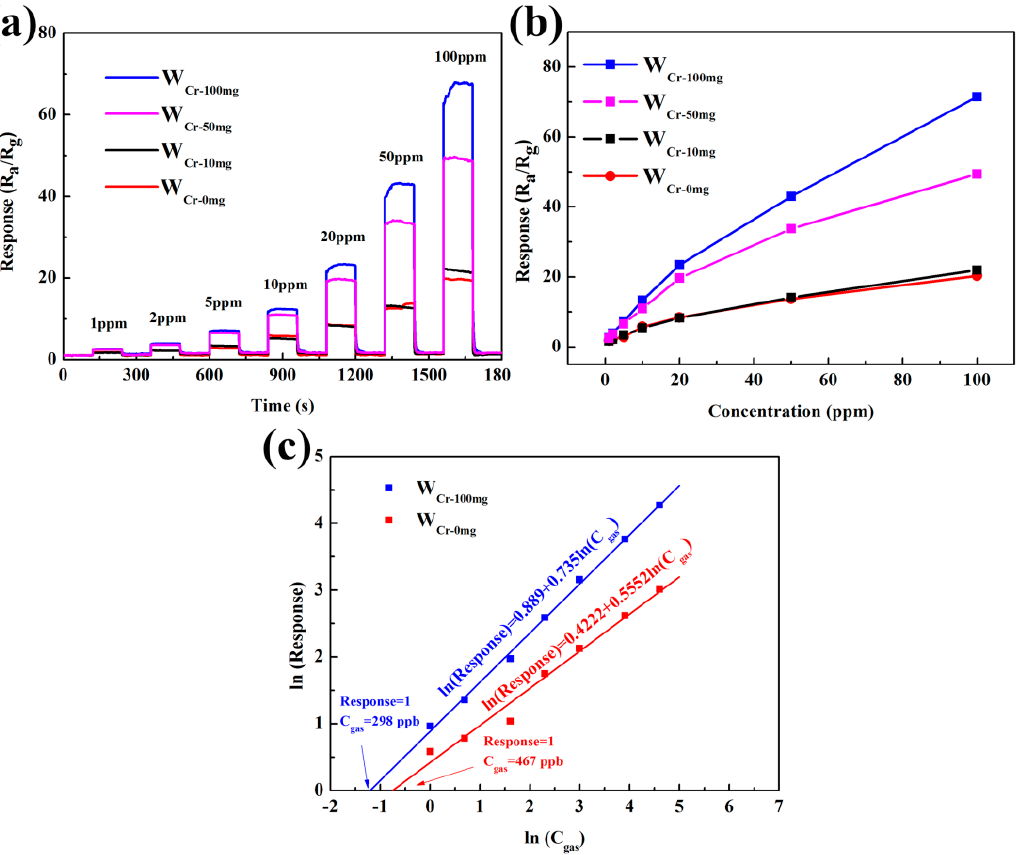
Figure 9. ( a ) Sensing transient curve of the sensors based on W Cr-0mg , W Cr-10mg , W Cr-50mg and W Cr-100mg to different concentrations of acetone ranging from 1 to 100 ppm measured at 250 °C at the relative humidity (RH) of 40%. ( b ) The corresponding responses to different acetone concentrations for the sensors. ( c ) The relationship between ln(Response) and ln(C gas ).